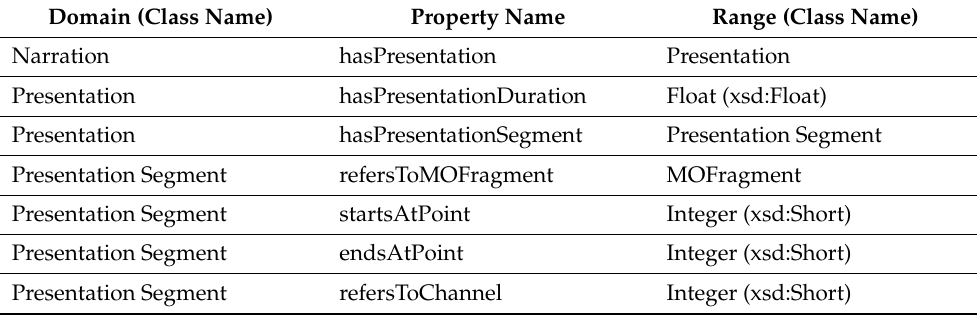
Table 4. Properties for the modelling of